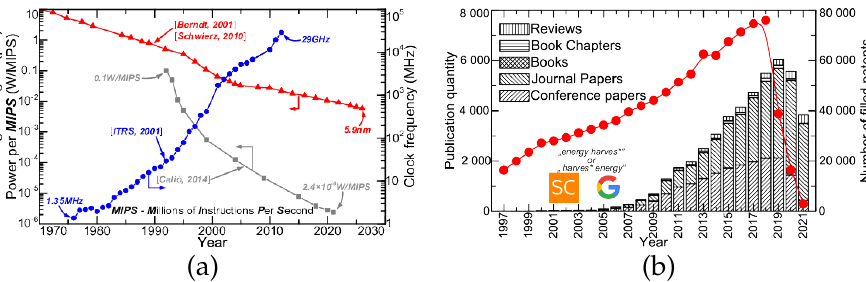
Figure 2. ( a ) Historical evolution of the electron devices performance revealing the miniaturization trend [13,14] (red line), operational frequency boost [15] (blue line) and reduction of power required per millions instruction per second (MIPS) [16] (gray line); ( b ) development of the energy harvesting in number of scientific publications after Scopus (bar plot) and patent applications (red line) following Google Patents.